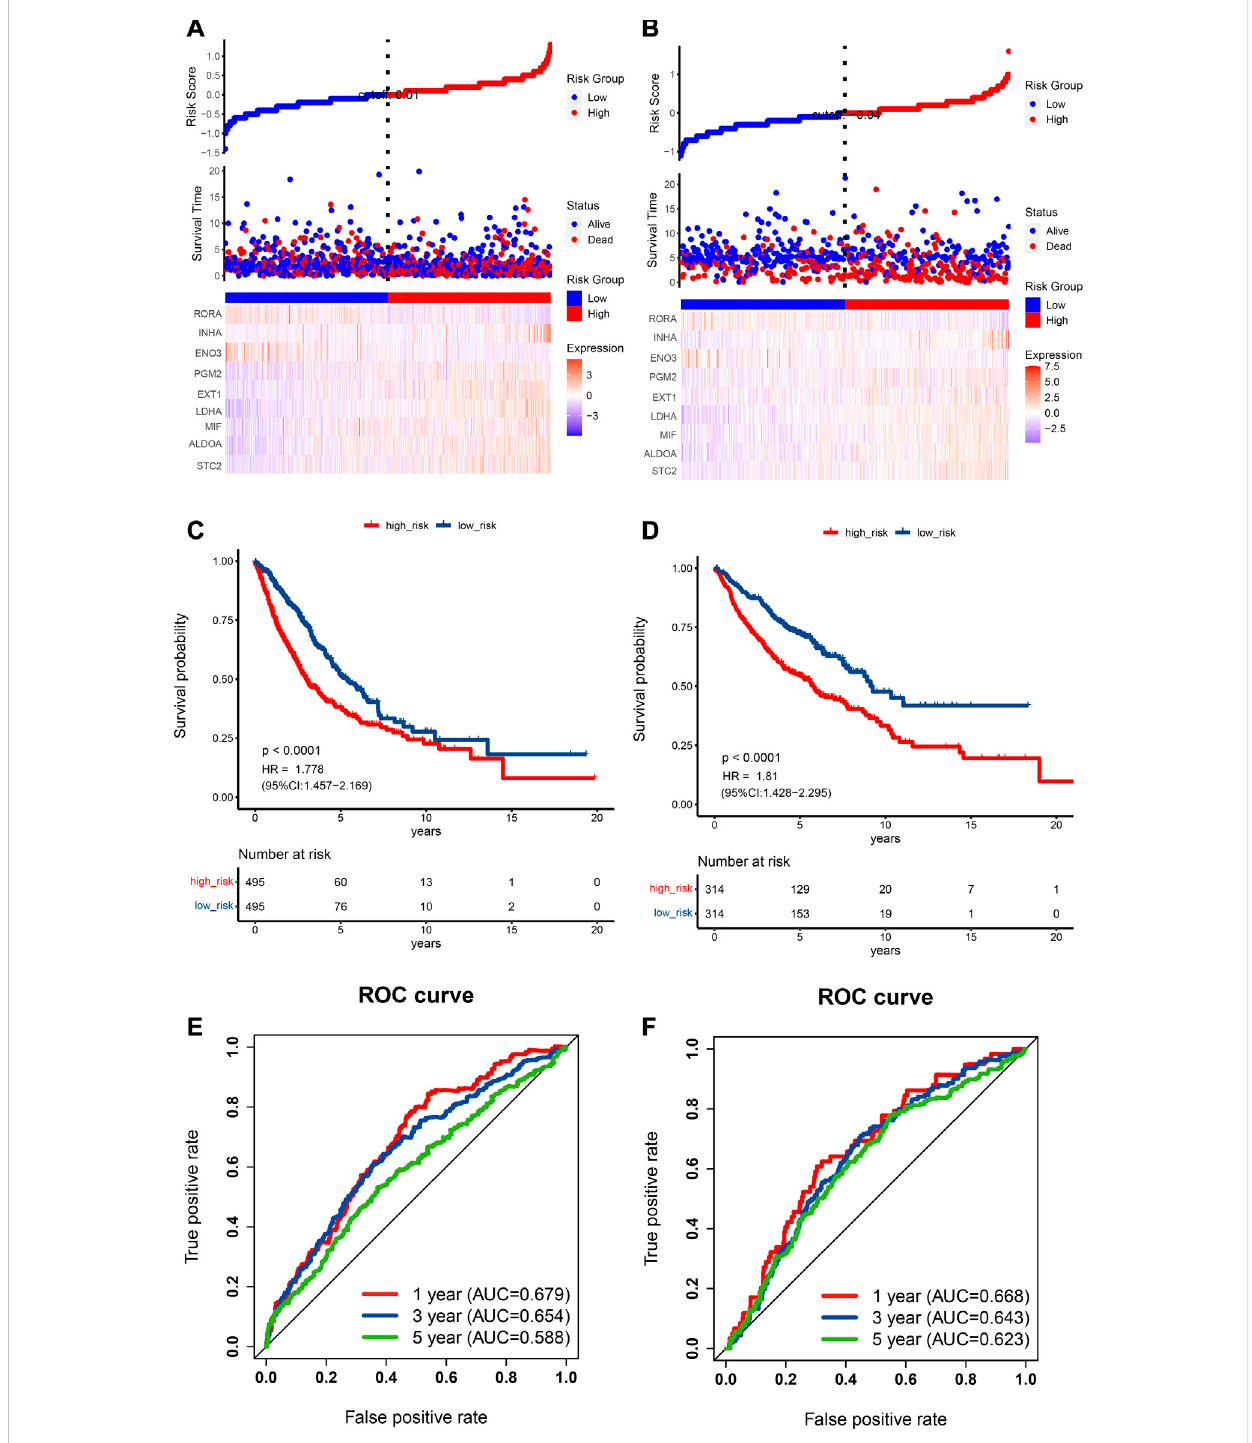
FIGURE 4 Prognosticdataanalysisfromthetrainingandvalidationcohortsaswellasveri fi cationofthemodel ’ sprecision. (A,B) Theriskscorecurveisdisplayed inthetoppart.Thedistributionoftheriskscore,survivalduration,andpatientstatusarepresentedinthemiddlepart.AheatmapofHRGsintheclassi fi eris shown in the bottom part. (A) TCGA cohort, (B) GEO cohort. (C,D) NSCLC patient Kaplan ‒ Meier survival curve comparing two risk categories. (C) TCGA cohort, (D) GEO cohort. (E,F) ROC curve in the TCGA cohort (E) and GEO cohort (F)